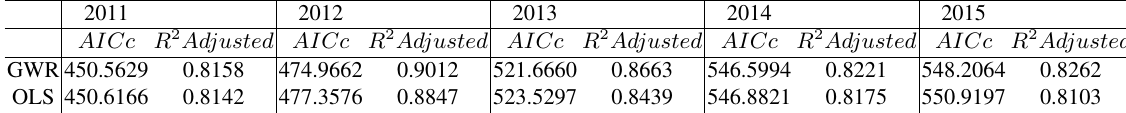
Table 4. The comparison of GWR and OLS